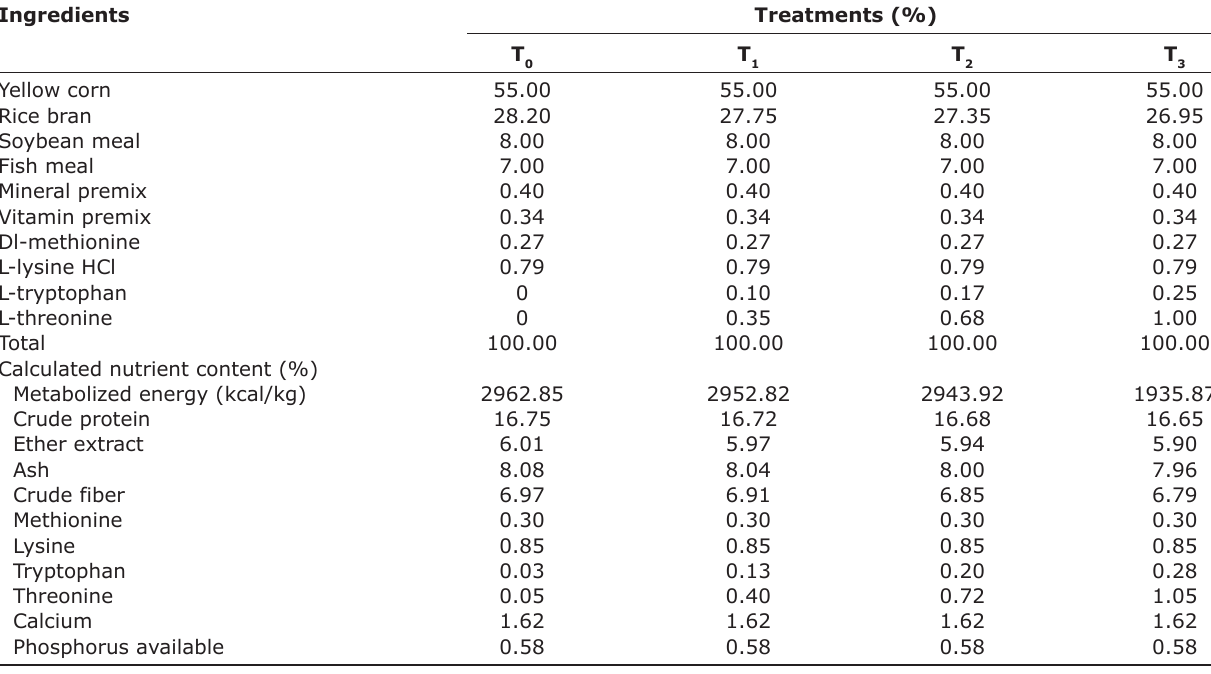
Table-1: Composition (%) and nutrient content (% dry matter) of experimental diets during the starter phase (1-6 weeks). Ingredients